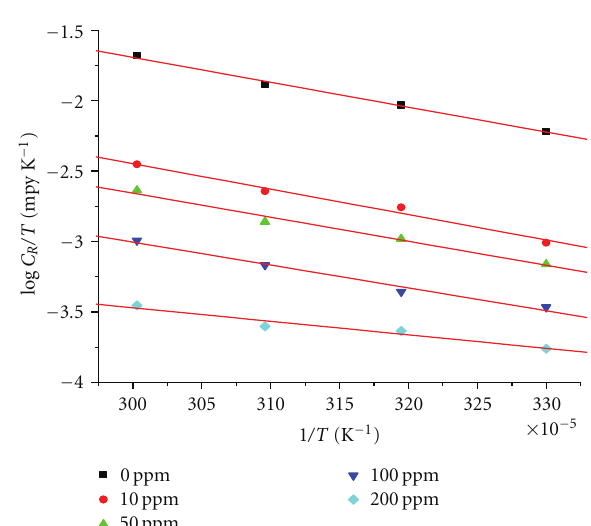
Figure 6: Transition plot for mild steel in 1M HCl solution in the absence and presence of di ff erent concentrations of the